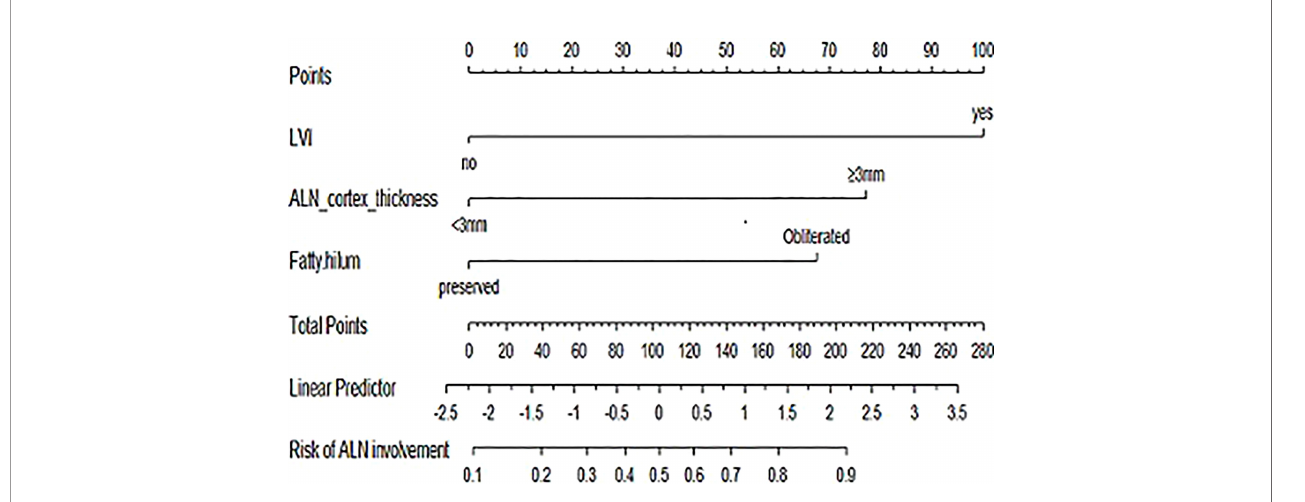
FIGURE 1 | Nomogram for the prediction of ALNM in patients with breast cancer.